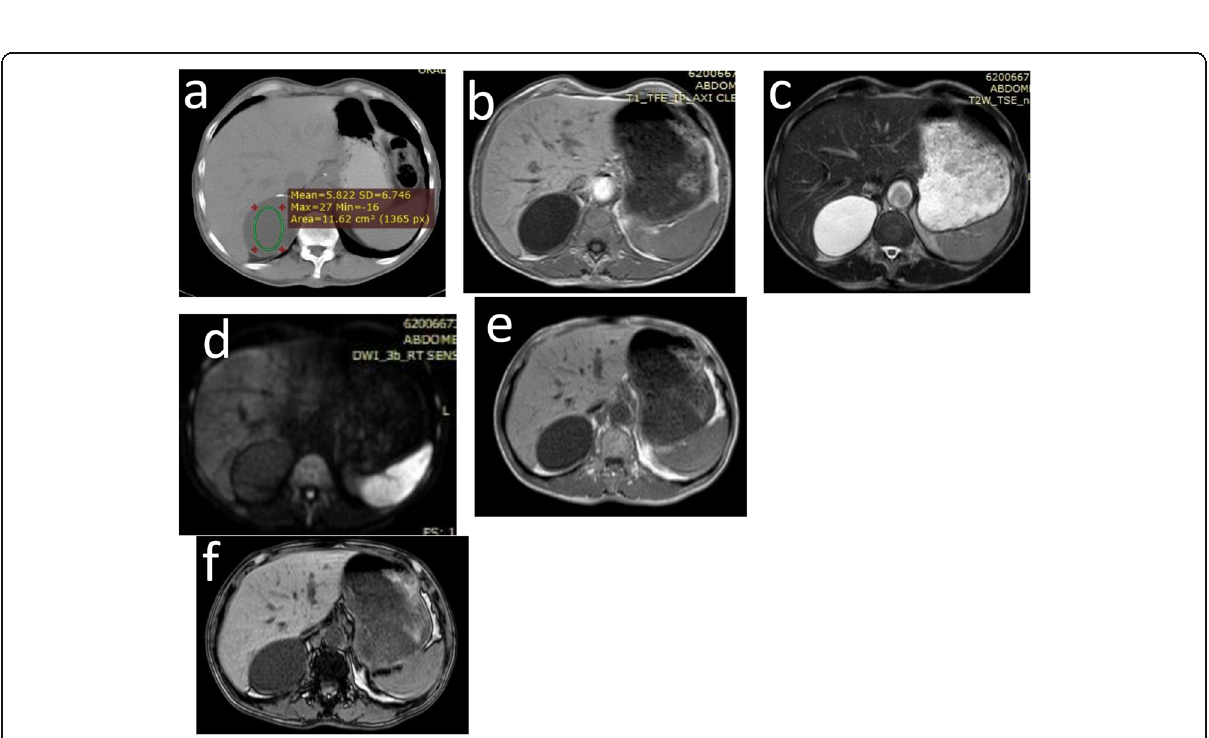
Fig. 6 A 50-year-old female patient came to the ER then referred to Urology Department complaining of left loin pain of gradual onset and progressive course over the past few months. a Axial non-enhanced CT of the abdomen showing a rather large soft tissue mass lesion measuring 6.6 × 5.2 cm along maximum axial dimensions implicating the right suprarenal gland region with mean attenuation of 19 HU in unenhanced images. MRI of abdomen adrenal protocol showing a large-sized right suprarenal soft tissue mass lesion eliciting intermediate signal in both T1 ( b ) and T2WIs ( c ), bright signal in diffusion ( d ) denoting restricted diffusion and showing no signal drop from the in phase to the out phase images ( e , f ). Diagnosis was right suprarenal malignant neoplastic lesion and was confirmed pathologically to be an adreno-cortical